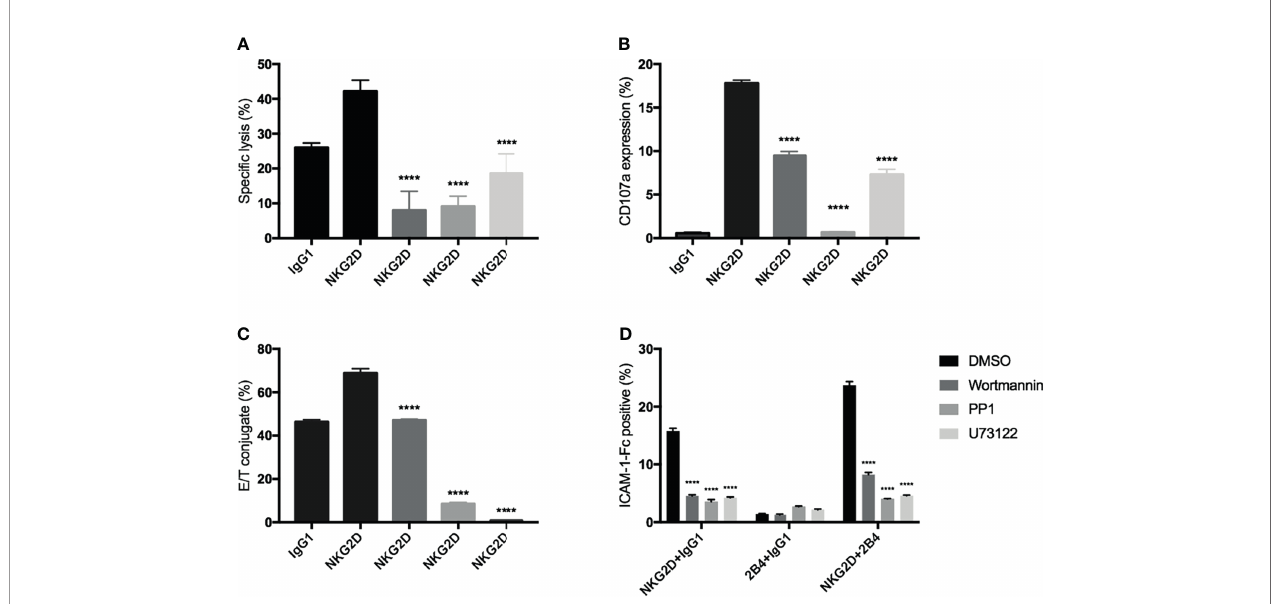
FIGURE 6 | Signaling inhibition by chemical inhibitors to block the NKG2D-mediated activities in CIK cells. Bulk CIK cells were preincubated with various signaling inhibitors (DMSO control, wortmannin [PI3K inhibitor], PP1 [Src kinase inhibitor], and U73122 [phospholipase C- g inhibitor]) and then stimulated with P815 cells preloaded with indicated antibodies (5 µg/ml) (A – C) or stimulated with anti-NKG2D, anti-2B4, or both (1 µg/ml) by cross-linking the receptors with goat F(ab)2 anti- mouse IgG (D) . (A) Cytotoxicity assay was performed as described in Figure 3A . (B) Degranulation was performed as described in Figure 3B . (C) Conjugate assay was performed as described in Figure 3D . (D) The activation level of LFA-1 was measured by staining with ICAM-1 – Fc complexes. The data are represented as mean ± SD of triplicates per condition and one representative of three independent experiments. **** p < 0.0001 calculated by one-way or two-way ANOVA, Bonferroni ’ s post-hoc